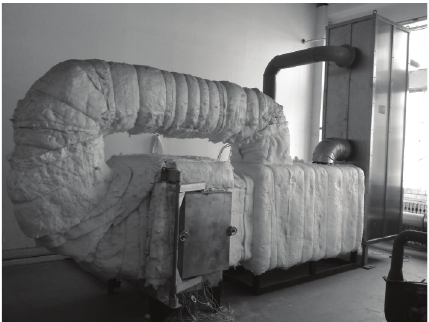
Figure 2: General view of the research and demonstration of preheated catalytic oxidation reactor